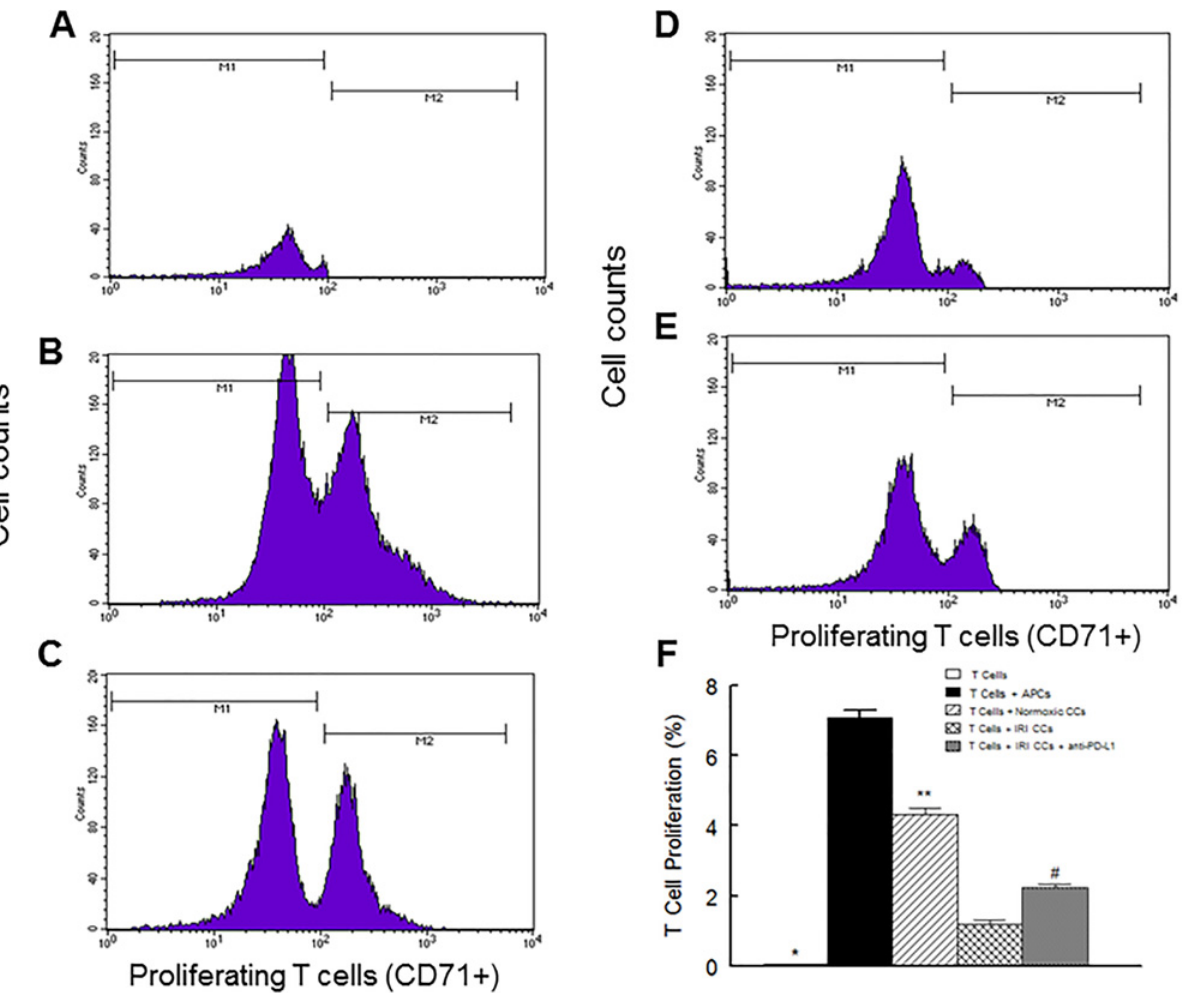
Fig 7. Panels A-E show representative histograms for proliferative pattern of T lymphocytes (i.e., CD71+). Panel A shows T lymphocytes alone while panel B shows T lymphocytes co-cultured with antigen presenting cells (APCs). On the other hand, panel C shows the pattern for co-culturing of T lymphocytes with normoxic cardiac cells (CCs) while panels D and E show patterns for T lymphocyte co-cultured with ischemic-reperfused CCs in the absence and presence of the PD-L1 blocking antibody, respectively. Panel F shows the percent of proliferating T lymphocytes under each condition; data are average of the triplicate samples for each heart (n = 3 hearts/group/condition). IRI: Ischemia Reperfusion Injury. * p < 0.05 compared to other groups. ** p < 0.05 compared to APCs or ischemic-reperfused CCs conditions. # p < 0.05 compared to their untreated